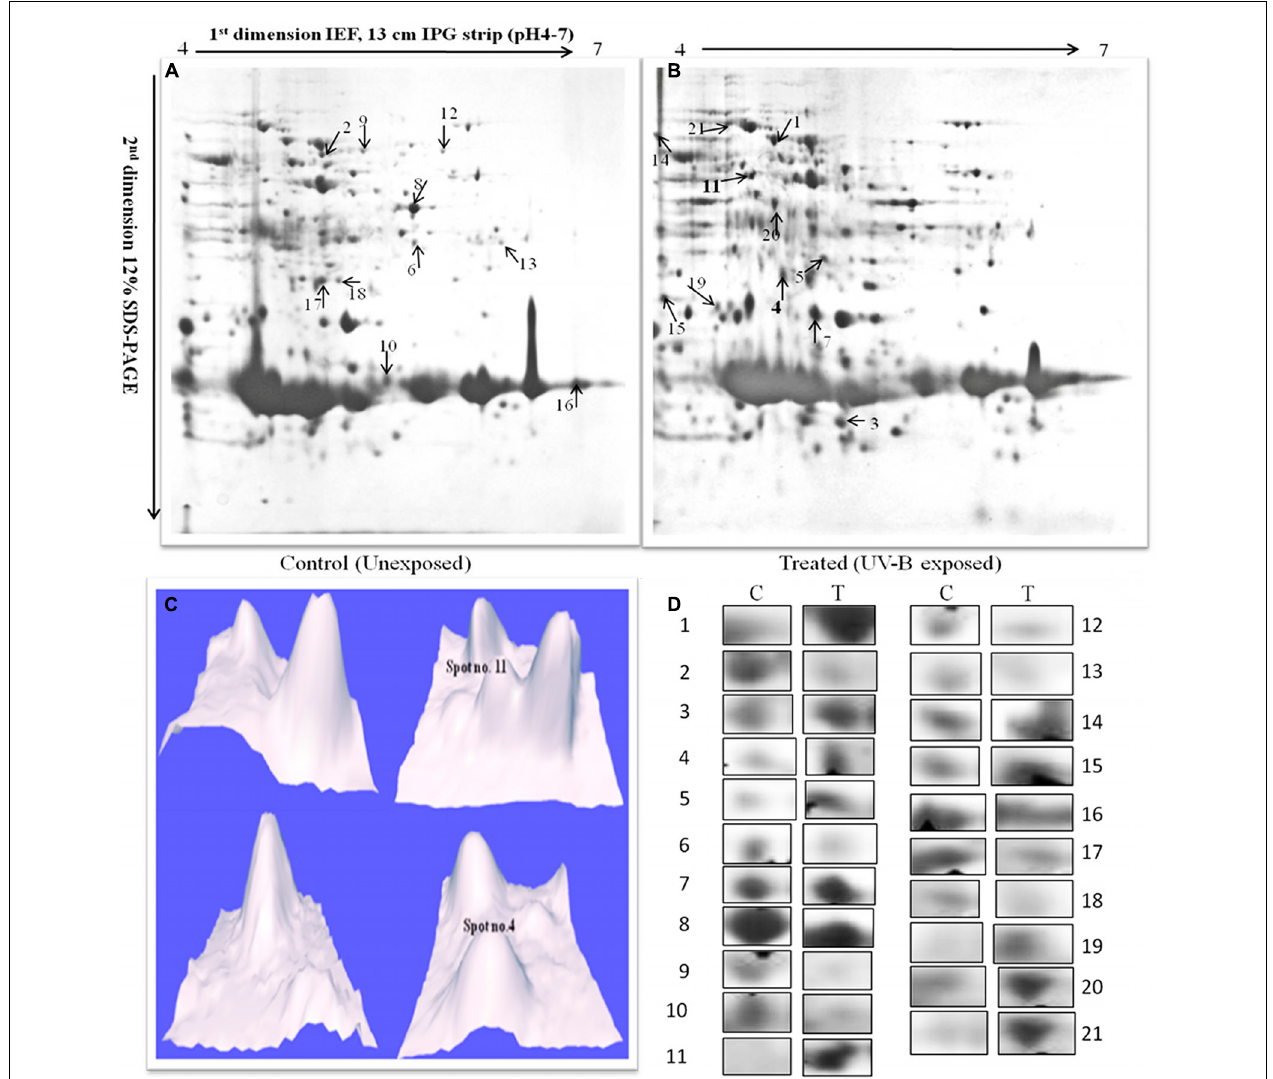
dimension. (C) -3-D images of the hypothetical protein spots shown in bold numbers on 2-DE gels, and (D) -expression pattern of selected proteins. Lane: C-control, andT- 9 h of UV-B treatment. Numbers represent the spots as indicated on 2-DE gels. Proteins showing significant and reproducible changes were subjected to